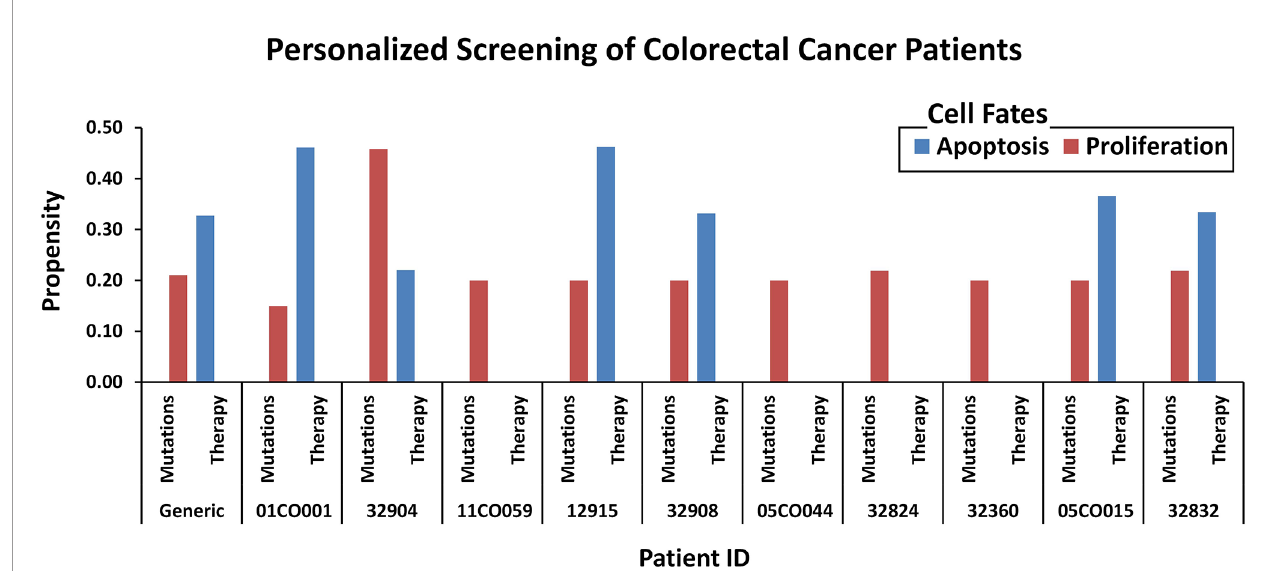
FIGURE 7 | Comparison of oncogenic cell fate propensities obtained from personalized screening. Personalized screening of ten colorectal cancer patients. Patient ID and mutation data were extracted from cBioPortal and cell fates for apoptosis and proliferation were plotted to observe before and after therapy